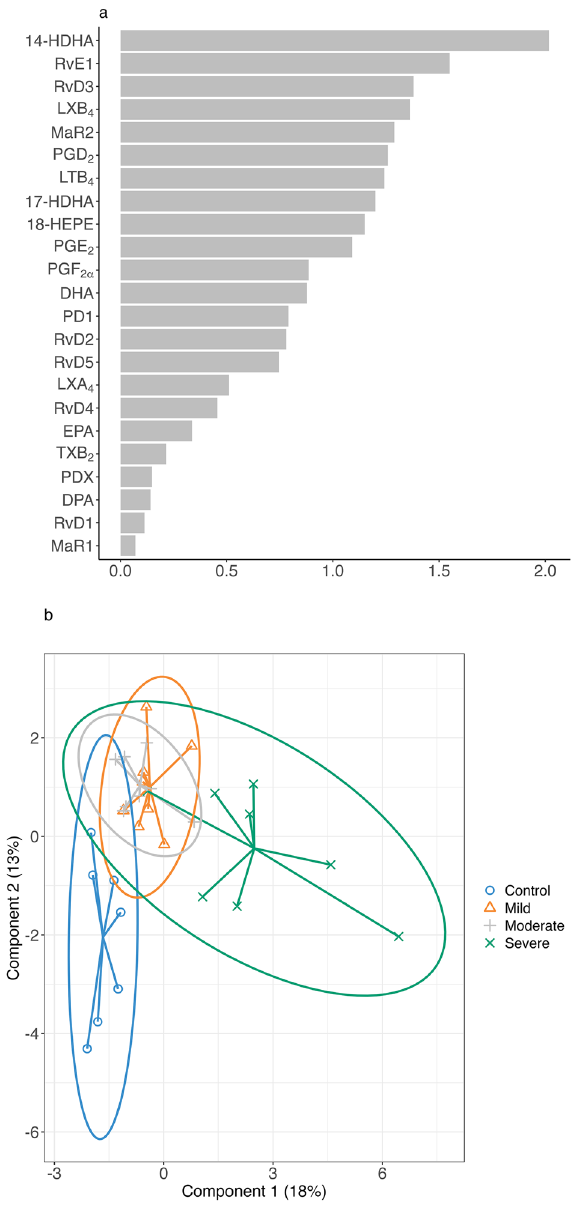
Figure 3. sPLS-DA analysis of active lipid mediators and precursor ω3-PUFA concentrations for discriminanting the four groups of patients (control, mild, moderate, and severe). ( a ) Variable importance in projection (VIP) scores of the lipid mediators and precursors. VIP larger than 1 highlights the most relevant indicators for identifying the four groups of study. Abbreviations: hydroxy docosahexaenoic acid (HDHA), resolvin (Rv), lipoxin (LX), maresin (MaR), prostaglandin (PG), leukotriene (LT), hydroxyeicosapentaenoic acid (HEPE), docosahexaenoic acid (DHA), protectin (PD), eicosapentaenoic acid (EPA), tromboxane (TX), and docosapentaenoic acid (DPA). (b) sPLS-DA sample plot with 95% confidence ellipse plots. A star plot displays arrows from each group centroid towards each individual